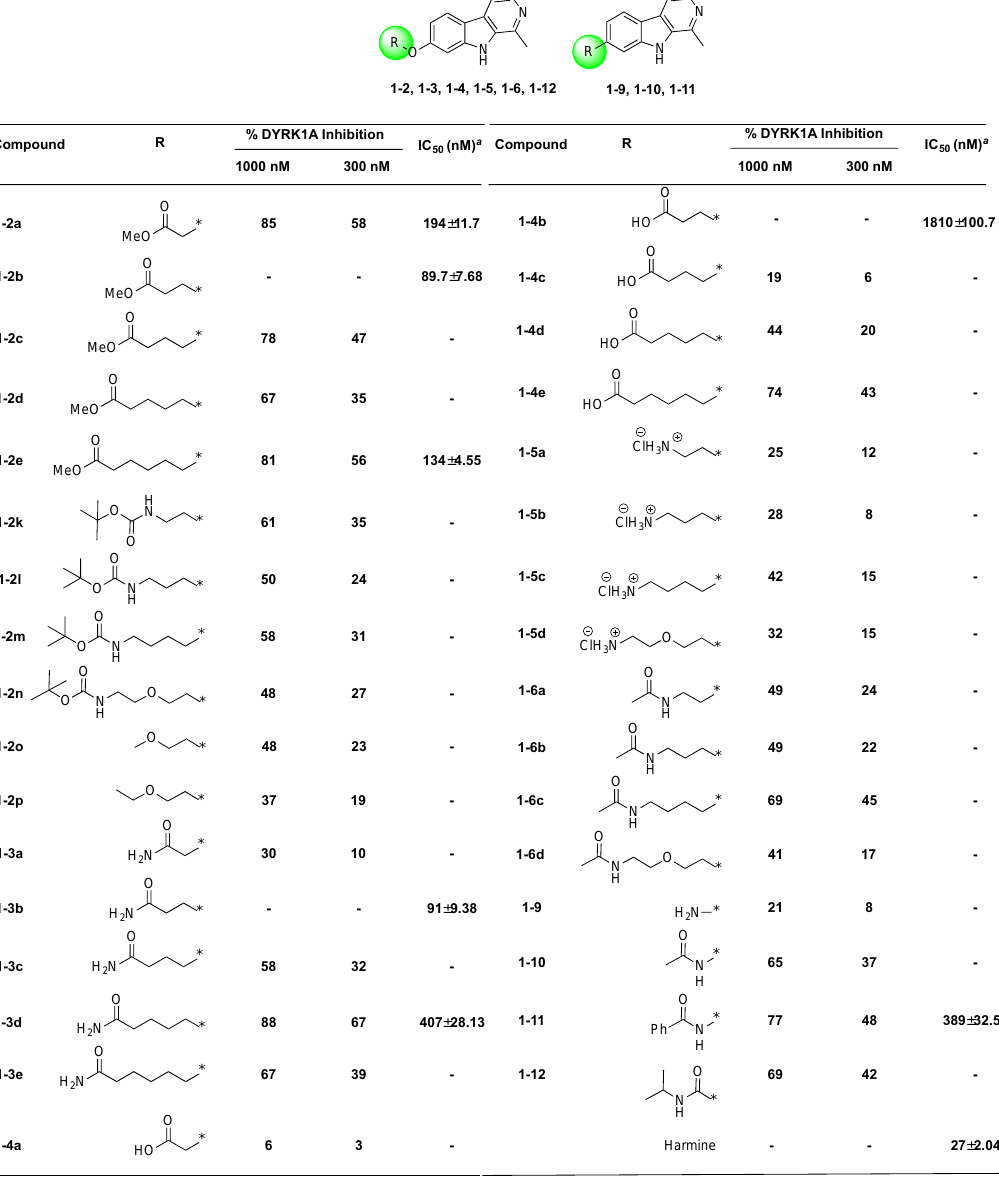
Figure 2. Dual-specificity Tyrosine-phosphorylation-Regulated Kinase A (DYRK1A) inhibition of 7-C harmine analogs a